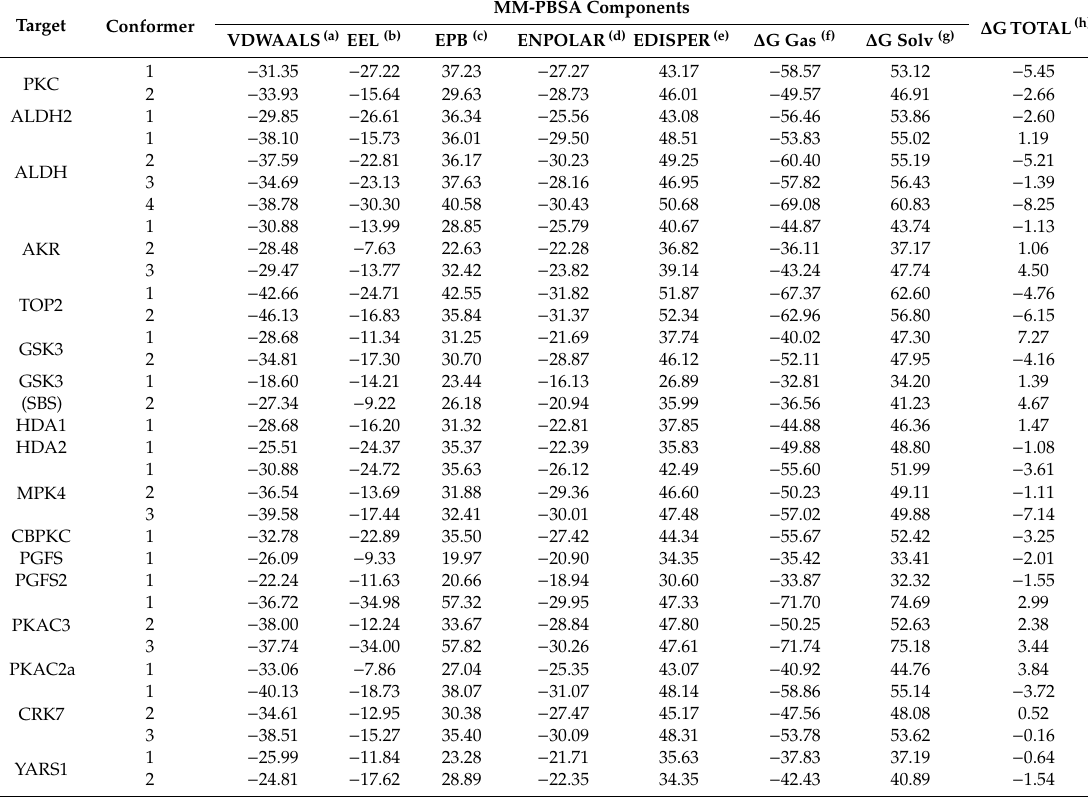
Table 4. Predicted free energies of binding of compound 9 to its predicted targets. The components of the free energies of binding are also included. All energies are expressed in kcal /